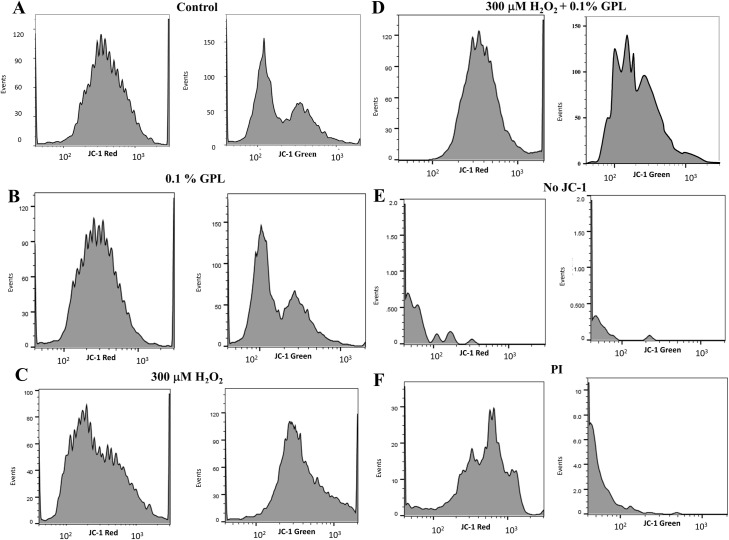
Histograms of red and green fluorescence intensity of sperm stained with JC-1.(A) Histograms of fluorescence of sperm red (left panels) and green (right panels) fluorescence intensities obtained after the control incubation (semi-log scale). (B) Fluorescence histograms of sperm obtained after incubation with 0.1% GPL. (C) Fluorescence histograms of sperm obtained after incubation in 300 μM H2O2. (D) Fluorescence histograms of sperm after exposure to 300 μM H2O2 in the presence of 0.1% GPL. (E) Fluorescence histograms of sperm cells without JC-1. (F) Fluorescence histograms of sperm in the presence of propidium iodide (PI).